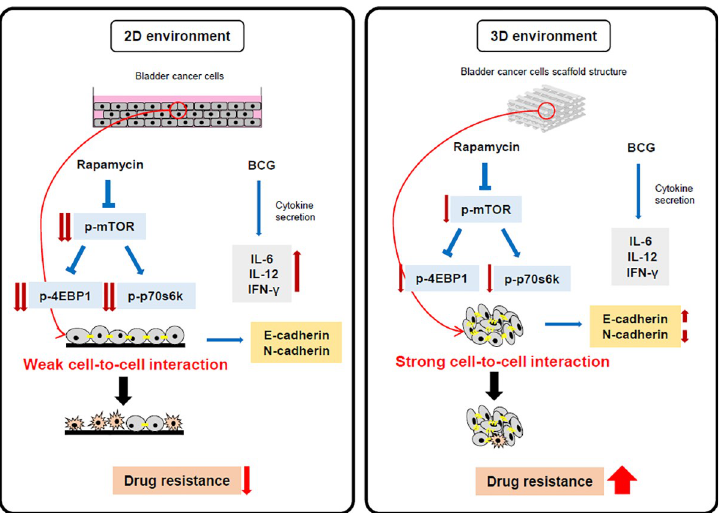
Fig 6. Hypothetical schema of comparison of drug resistance effect in 2D and 3D environments due to cell-to-cell interaction. The 2D cell culture environment and 3D cell culture environment reacted to rapamycin and BCG treatment, and there were strong differences. The mTOR signal pathway was more highly blocked by rapamycin in 2D than in 3D. The secretion of IL-6, IL-12, and IFN- γ , which are antitumor cytokines, due to BCG was also increased more in 2D than in 3D, resulting in an enhanced antitumor effect on bladder cancer cells. This indicates that our model confirms the secretion of E-cadherin and N-cadherin and shows the difference in drug resistance according to the difference in the intensity of cell-to-cell interaction. The results provide a rationale for evaluating drugs using the 3D cell culture environment.